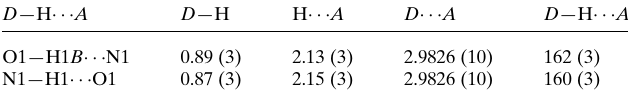
Table 1 Hydrogen-bond geometry (A˚ , (cid:3) ) for 1 .